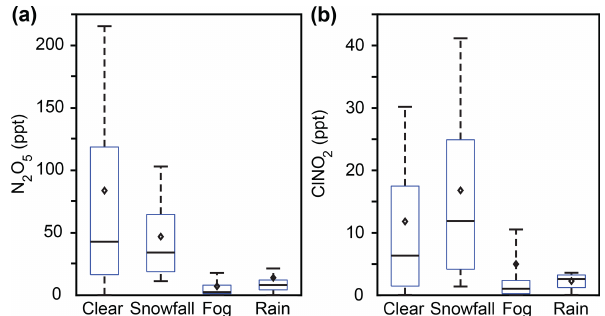
Figure 2. Box plots showing 30min averaged mole ratios of (a) N 2 O 5 and (b) ClNO 2 during clear conditions and weather events (snowfall, fog, and rain) from the entire campaign, 20 January– 24 February. Bars represent the 10th, 50th, and 90th percentiles; boxes represent the 25th and 75th percentiles; and diamonds repre- sent the means. Only nighttime data between 18:00 and 08:00EST are included. Data during all weather events (snowfall, fog, rain) are significantly different ( p < 0 . 05, t test) from clear